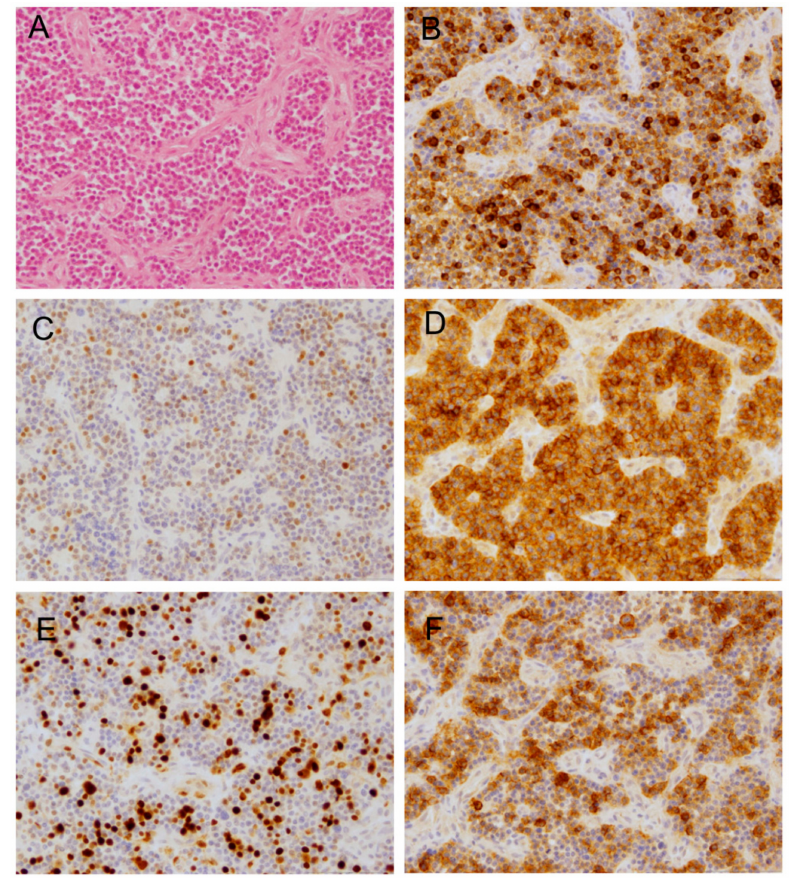
Figure 1. Histopathological features of the primary tumor. ( A ) HE staining showing small, round, blue tumor cells. ( B ) Epithelial antigens (EMA). ( C ) NeuN. ( D ) CD56. ( E ) Ki67. ( F ) L1Cam. Original magnification 200 ×